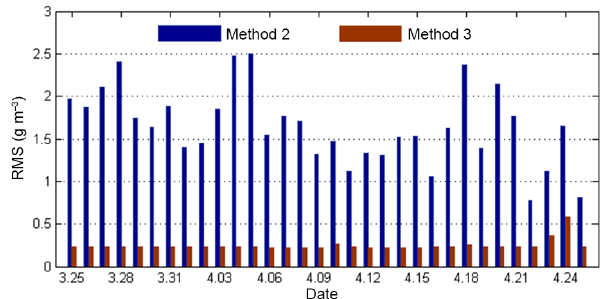
Figure 5. The number of initial water vapour density values derived from methods 2 and 3 in the experiment.